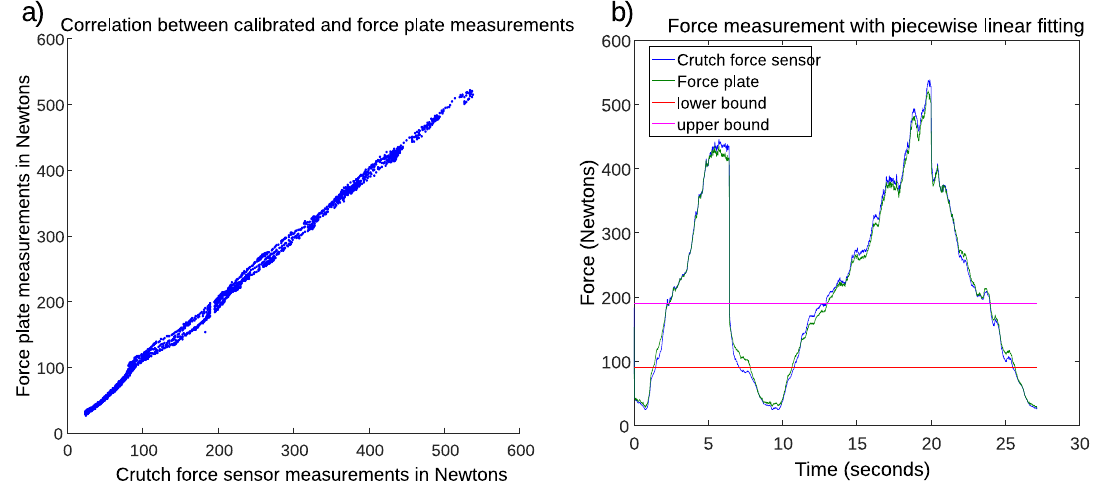
Figure 3. Results with data of the second recording after applying piecewise linear transformation. ( a ) Correlation between force plate and crutch force sensor measurements; ( b ) Evolution of force